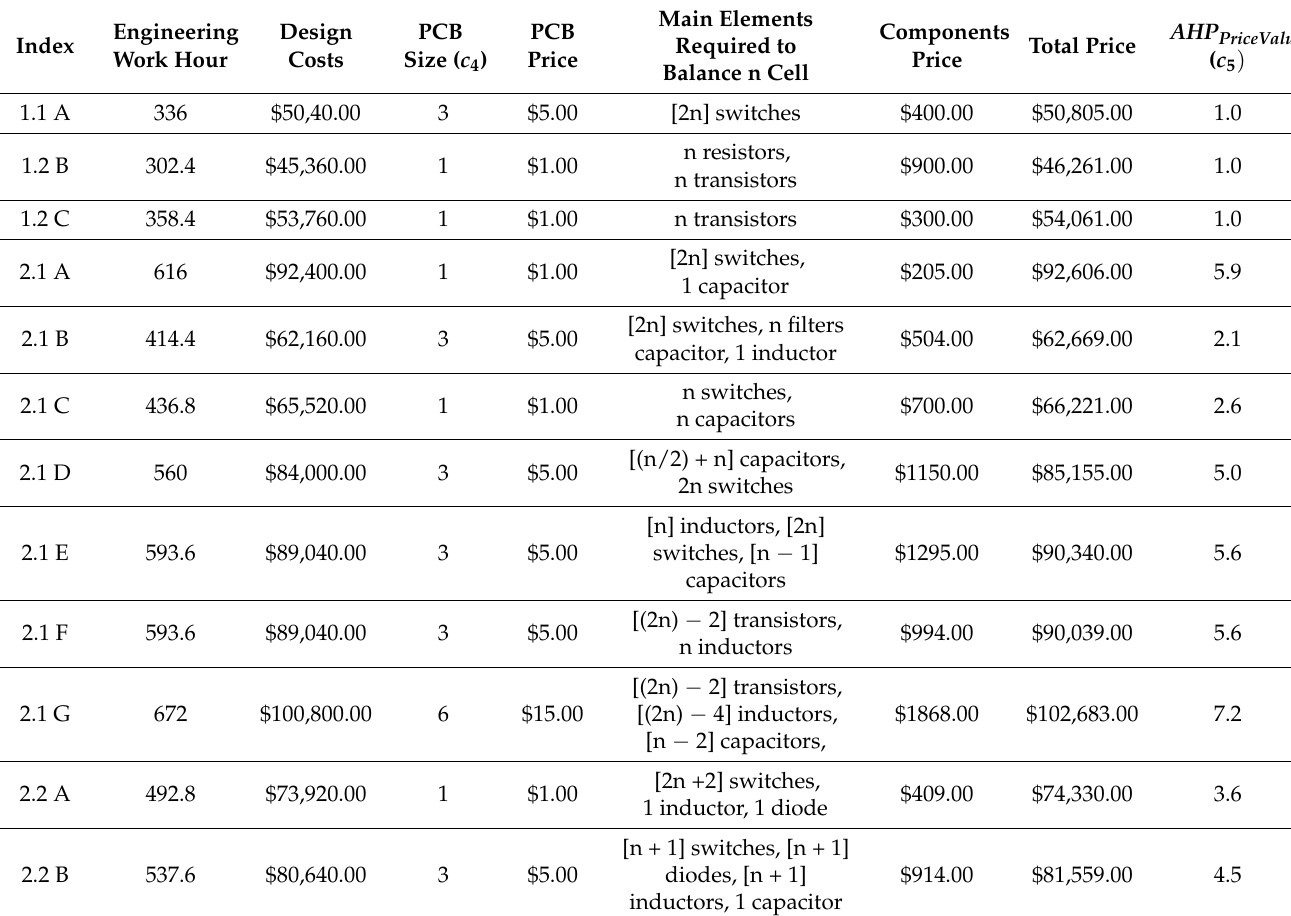
Table 9. Equalization method total price steps to convert it in a numerical value on AHP